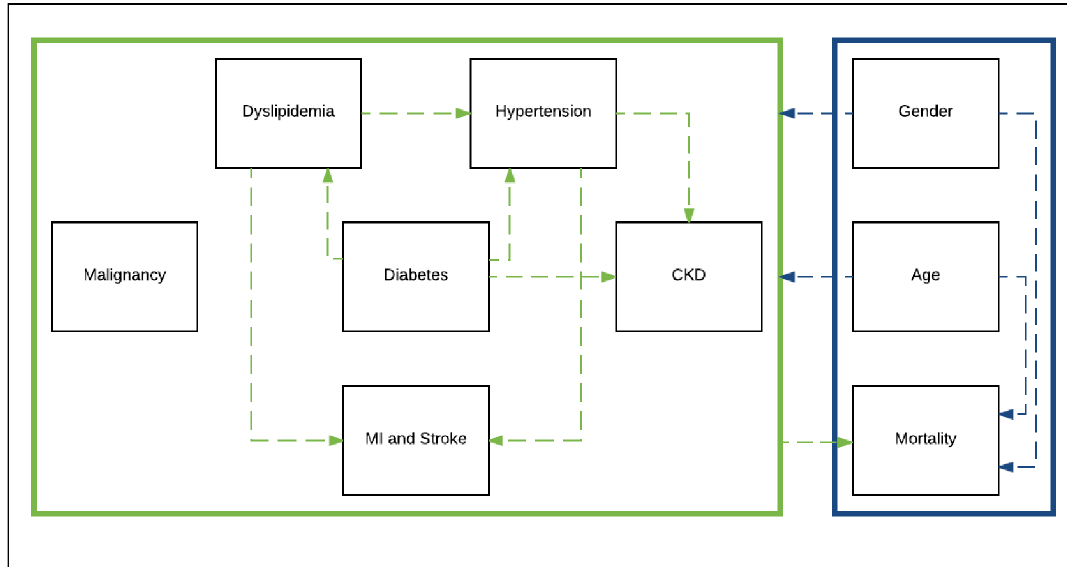
Fig 1. Basic schematic of the model design. The model follows patients on antiretroviral therapy from 2010 to 2035 or death. The model simulateshow patients age over time and developclinicalevents, includingnon-communicablediseases or death. The model takes into account key interactionsbetweendemographicfactors (blue), e.g. how age and gendercan impact risk of death, and clinicalfactors (green)e.g how hypertension can increasethe risk of chronic kidney diseaseor death. Adapted from source : Smit et al [9]. Abbreviations : MyocardialInfarction (MI) , ChronicKidney Disease (CKD) .